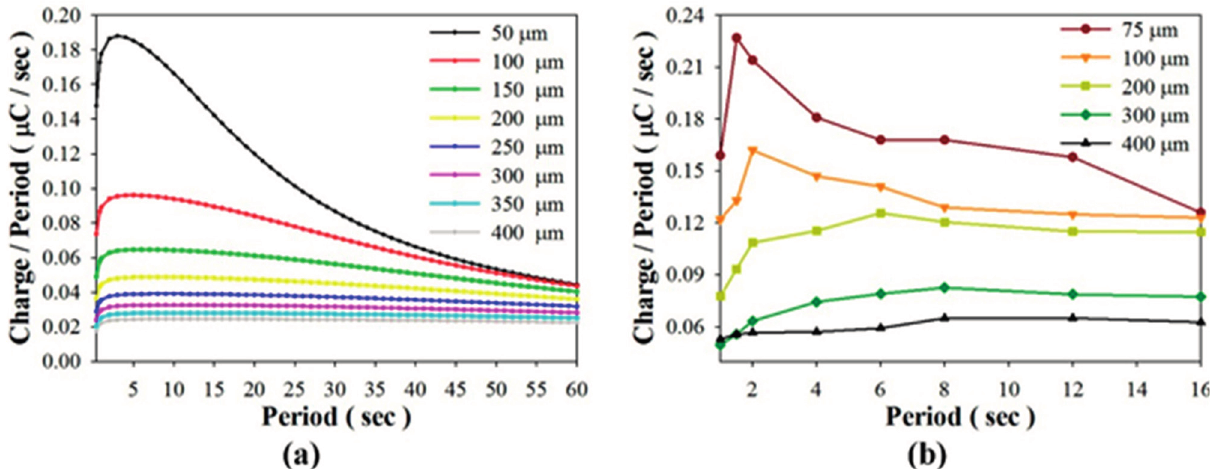
Figure 7. Relationships between the induced charge rate and various periods when using PZT cells of various thicknesses, as determined by simulated calculation ( a ); and experiment ( b